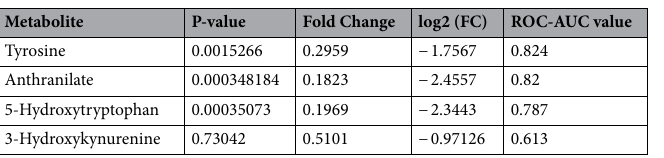
Table 2. Predictive ability of the individual potential biomarkers based on ROC curve